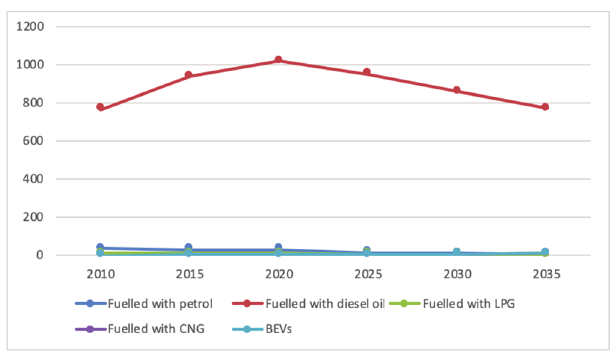
Fig. 3. Number of vehicles other than passenger cars with GVM above 3.5 tons by types of energy carriers in Poland in 2010 and 1015 and in the forecast up to year 2035